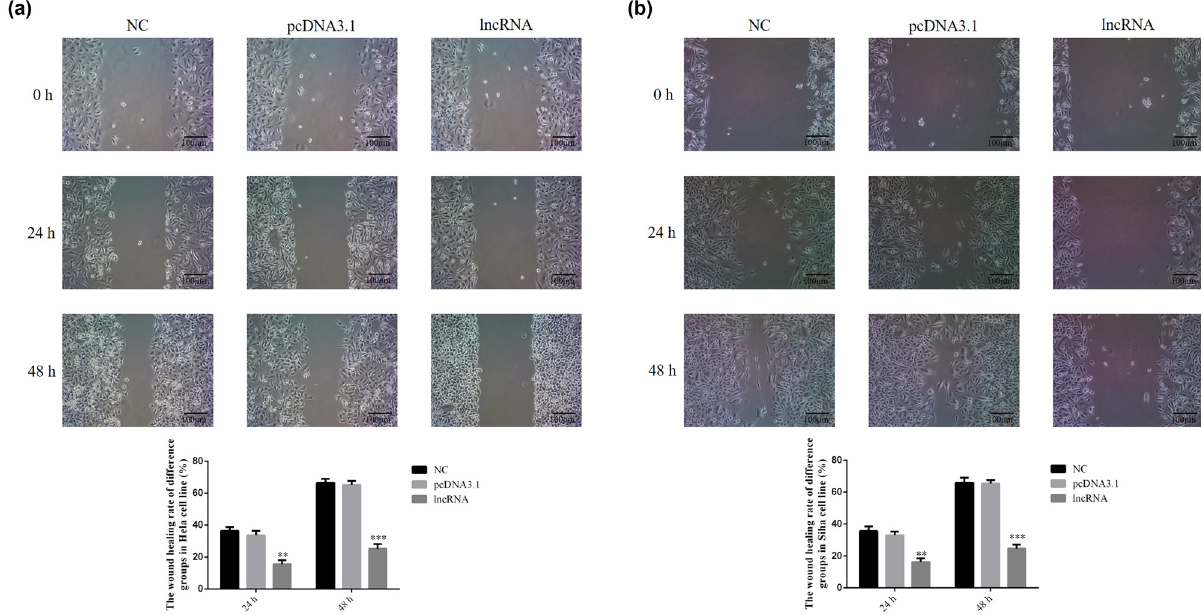
Figure 5: UBE2R2 - AS1 a ff ected the wound healing rate of di ff erence groups in HeLa and SiHa cell lines by wound healing assay ( 100 ×) . NC: normal control group; pcDNA 3.1: the cells were transfected with pcDNA3.1; lncRNA: the cells were transfected with UBE2R2 - AS1 by pcDNA3.1. ( a ) UBE2R2 - AS1 a ff ected wound healing rate of di ff erence groups in HeLa cell. *** P < 0.001, compared with NC group. ( b ) UBE2R2 - AS1 a ff ected wound healing rate of di ff erence groups in SiHa cell. *** P < 0.001, compared with NC